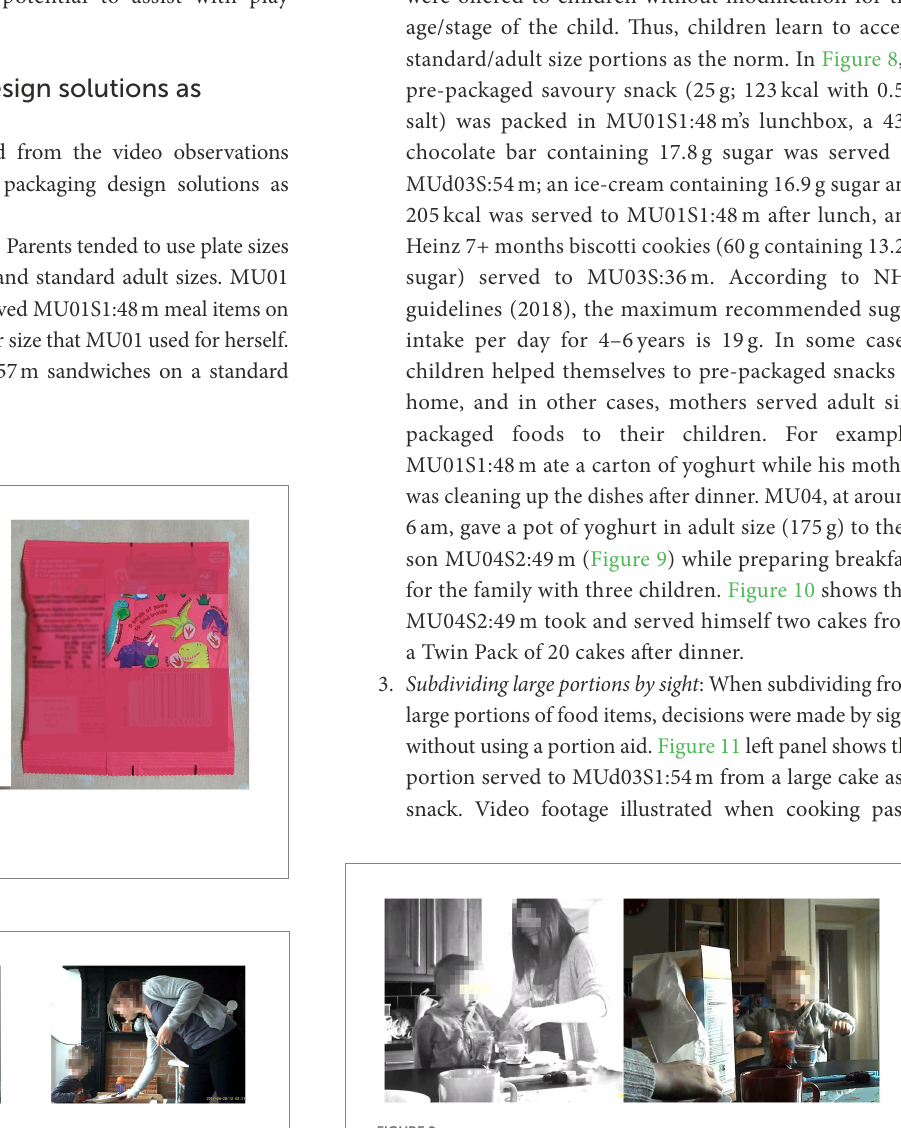
FIGURE 9 Pre-packaged adult size food offered to the child (MU04S2:49